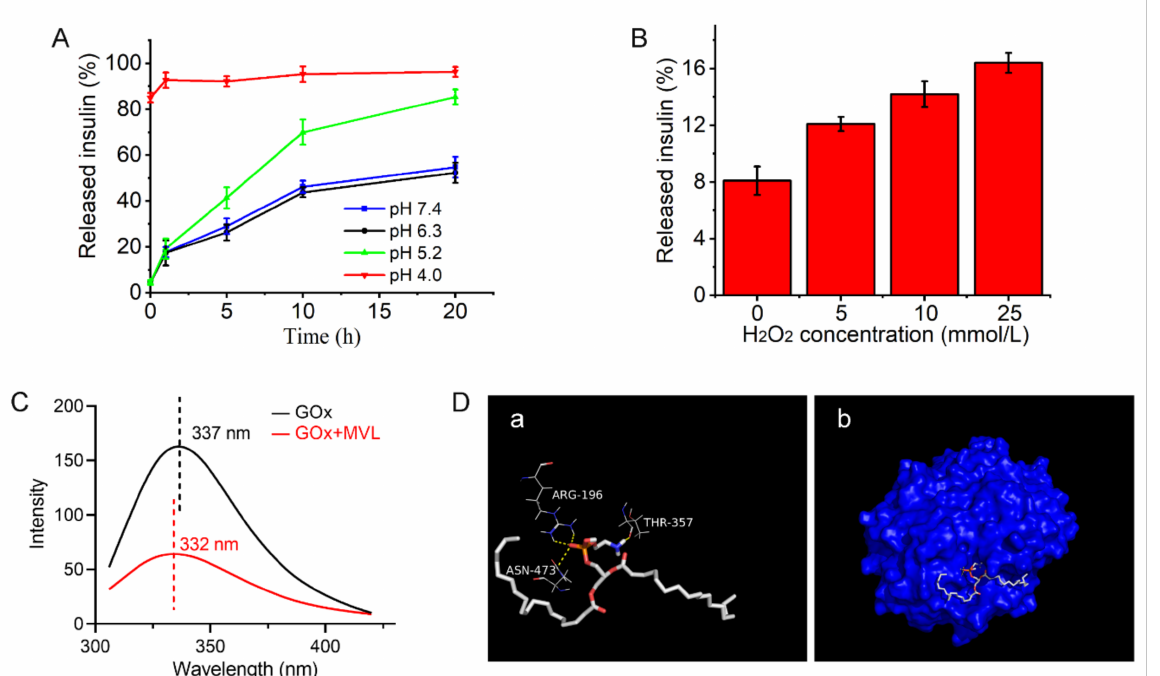
Figure 8. Glucose-responsive mechanism of MVL(F+E+I): ( A ) In vitro accumulated insulin release from MVL(F+E+I) in PBS with different gluconic acid concentrations at different pH levels. Data are shown as mean ± SD ( n = 3). ( B ) In vitro accumulated insulin release from MVL(F+E+I) in PBS (pH 7.4) with different H 2 O 2 concentrations at 0.5 h. The H 2 O 2 concentrations in the release media were calculated according to the BGLs under physiological conditions. Data are shown as mean ± SD ( n = 3). ( C ) Fluorescence emission spectra of GOx solutions in the presence and absence of blank MVLs. ( D ) Docking study of the interaction of DSPE with GOx. DSPE is shown as sticks. ( a ) Residues involved in the interaction with DSPE are labeled and shown as lines, with the remainder of GOx not shown. Hydrogen bonds are indicated by yellow doted lines. ( b ) GOx is shown as a